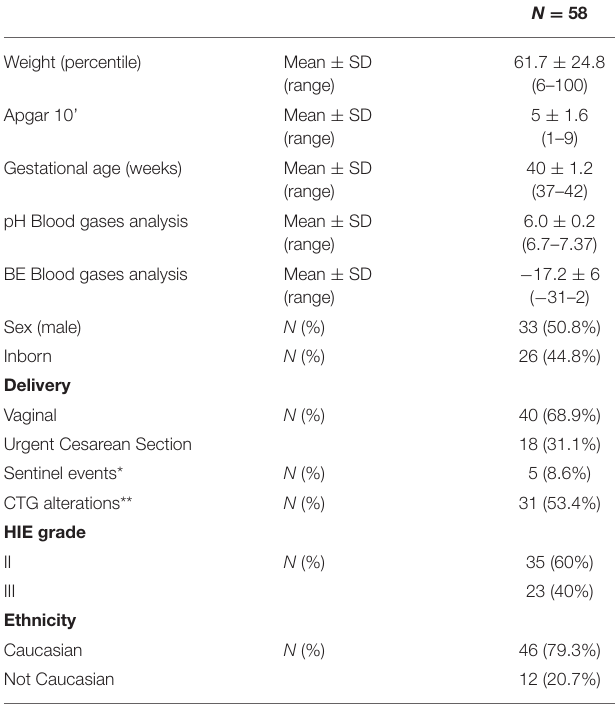
TABLE 1 | Perinatal clinical characteristics of HIE-cooled infants